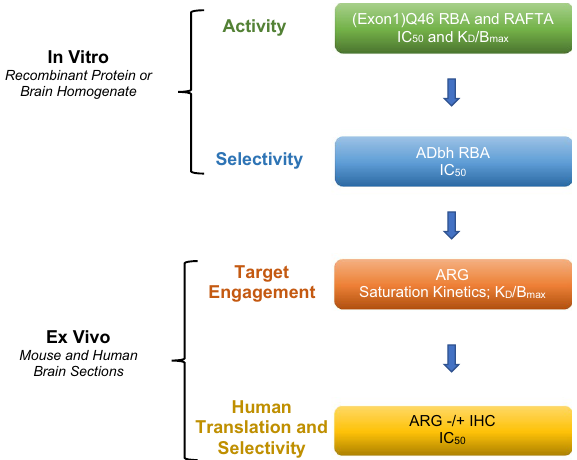
Figure 1. Screening Cascade of in vitro / ex vivo pharmacological